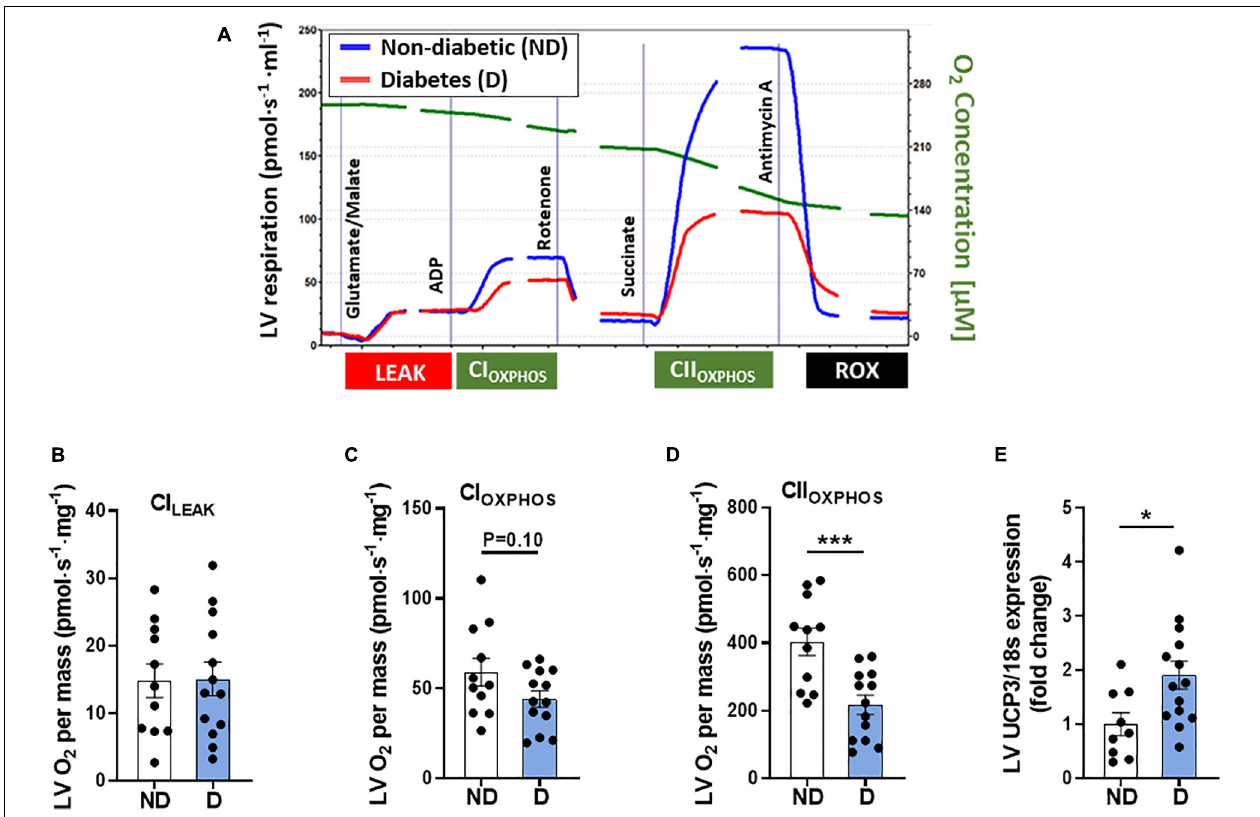
FIGURE 7 | LV mitochondria function in diabetic mice . (A) Representative mitochondrial oxygen consumption trace in diabetic mice (red line) and non-diabetic mice (blue line). Image has been cropped where lines are broken. Cytochrome C addition not shown. Oroboros high-resolution respirometry analysis of: (B) Complex-I LEAK respiration, (C) Complex-I oxygen consumption, (D) Complex-II oxygen consumption. LV gene expression of (E) mitochondrial uncoupling protein-3 (UCP3). Data represented as mean ± SEM. n = 9–14 per group (note individual data points). Data analysis was carried out using unpaired t -test. * P < 0.05, *** P < 0.001. ND, non-diabetic; D, diabetes; LV, left